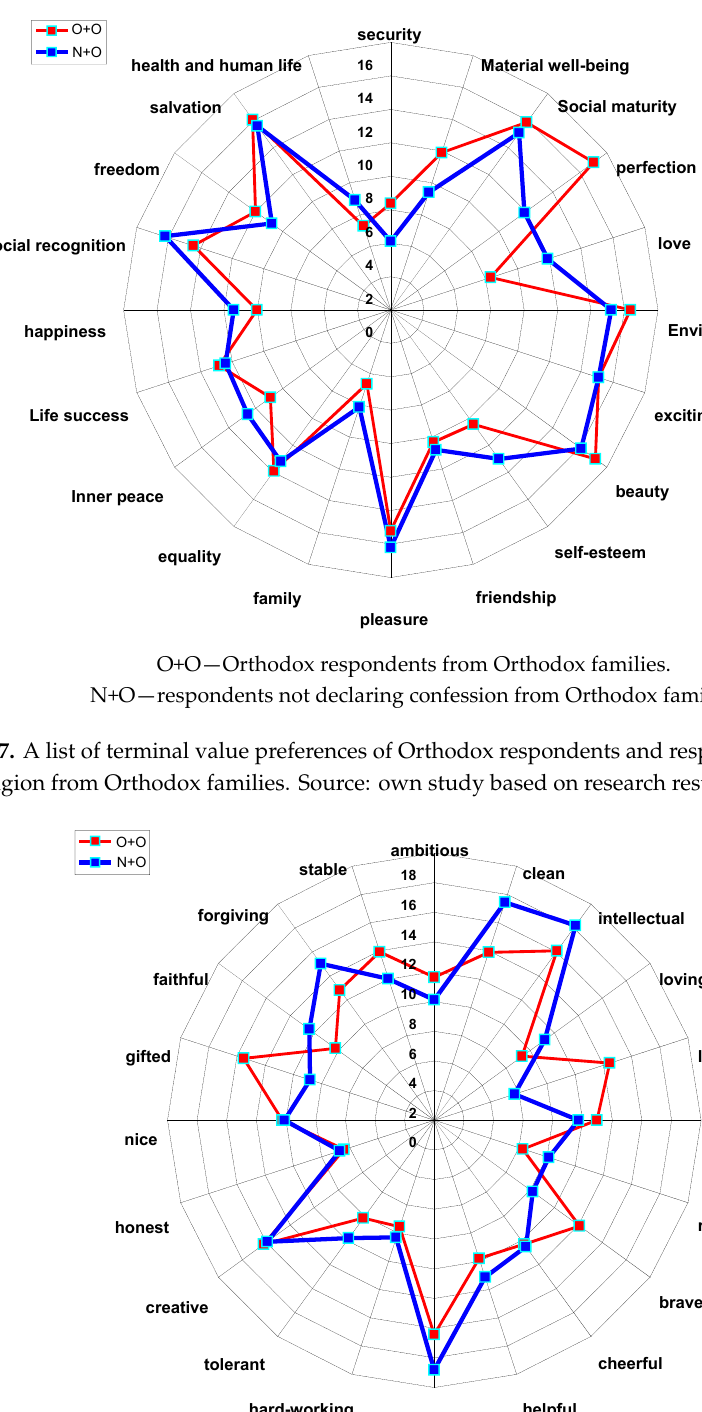
Figure 8. Comparison of instrumental value preferences of Orthodox respondents and respondents not declaring their denomination from Orthodox families. Source: own study based on research results.